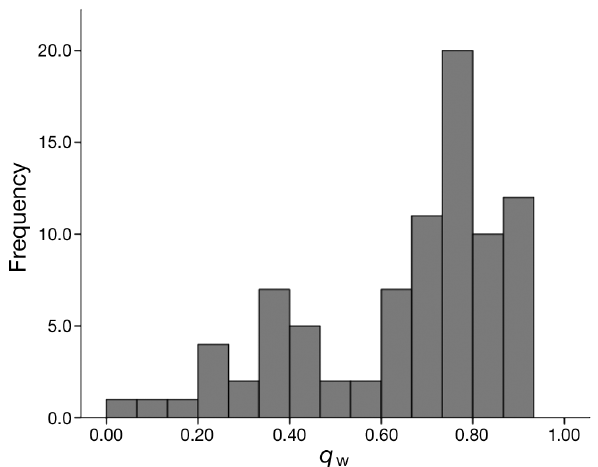
Fig. 6. Distribution of q W values (membership coefficients to the wild cluster) of all turbot individuals with some degree of farm ancestry detected with the 755 SNPs in the Atlantic Ocean and Baltic